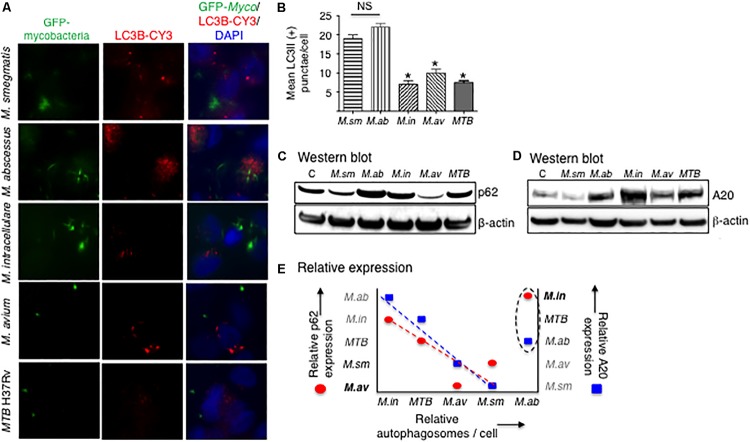
More virulent mycobacterial species generally induced less autophagosome formation. (A) Identification of autophagosomes by immunofluorescent detection of LC3II-positive particles 24 h after infection of THP-1 cells by the different mycobacteria. Shown photomicrographs are representative of three independent experiments. (B) Quantification of the number of autophagosomes, reported as the average number of autophagosomes per cell. Data represent the mean ± SEM of three independent experiments. (C) Immunoblot for p62 expression of THP-1 cells infected for 24 h with the mycobacterial species. (D) Immunoblot for A20 expression of THP-1 cells infected for 24 h with the mycobacterial species. Both immunoblots shown are representative of three independent experiments. (E) Qualitative graphical representation of the relative expression of autophagosome number as a function of p62 (red circles) and A20 (blue squares) expression. The dashed lines are an estimate of the lines of best fit, excluding points for M. abscessus. M. sm, M. smegmatis; M. ab, M. abscessus; M. in, M. intracellulare; M. av, M. avium; MTB, M. tuberculosis. *p < 0.05 compared to M. smegmatis. Multiplicity-of-infection of 10 mycobacteria:1 macrophage.